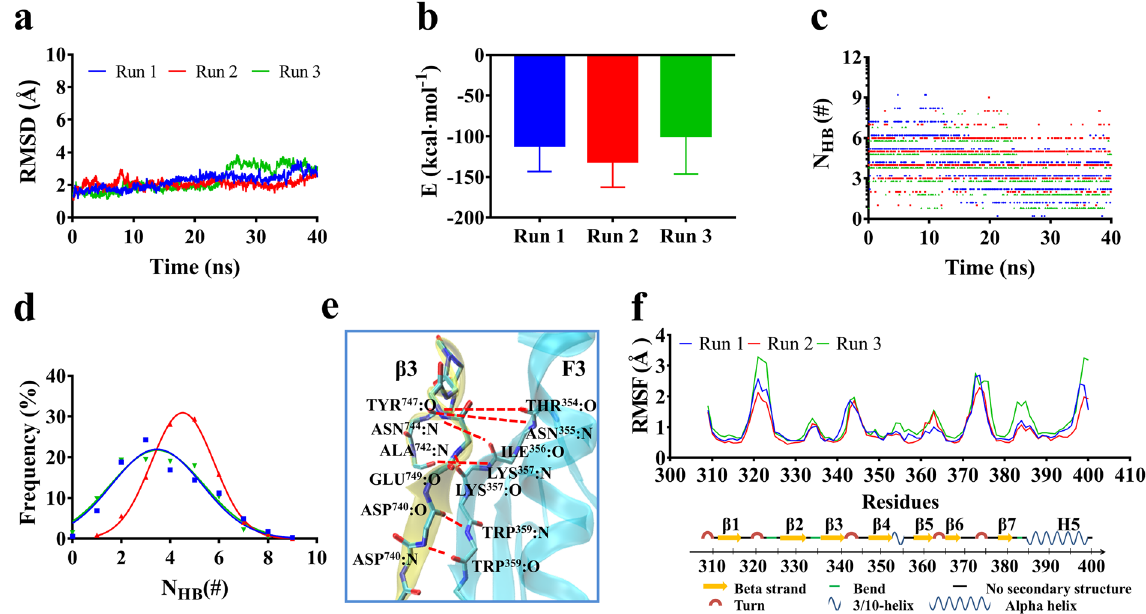
Figure 2. The dominant interactions of binding site residues in equilibrated complex of Talin F3 domain with CT domain of β3 integrin. ( a ) The time courses of Cα-RMSD, ( b ) the mean interaction energy over 40 ns for the equilibrated complexes, ( c ) the time course of interface H-bond number (N HB ) and ( d ) the N HB distribution with 40 ns for three Runs. The Cα-RMSD was limited in region from 1 to 4 Å, showing the system at equilibrium. The best fitting results of N HB frequency data showed a Gaussian distribution, and the maximum N HB and the minimum E were obtained in Run2, meaning that the equilibrated complex from Run2 was the best for subsequent simulations. Interaction between binding site residues of complex and RMSF pattern of residues on the ligated Talin F3 domain. ( e ) The key interface H-bonds (red dotted line) and their respective involved binding site residue pairs in complex of β3 integrin tail (yellow) with Talin F3 domain (cyan) in F3 domain. ( f ) The Cα-RMSF patterns of residues on equilibrated Talin F3 domains respectively for Run1 (blue), Run2 (red) and Run3 (green).